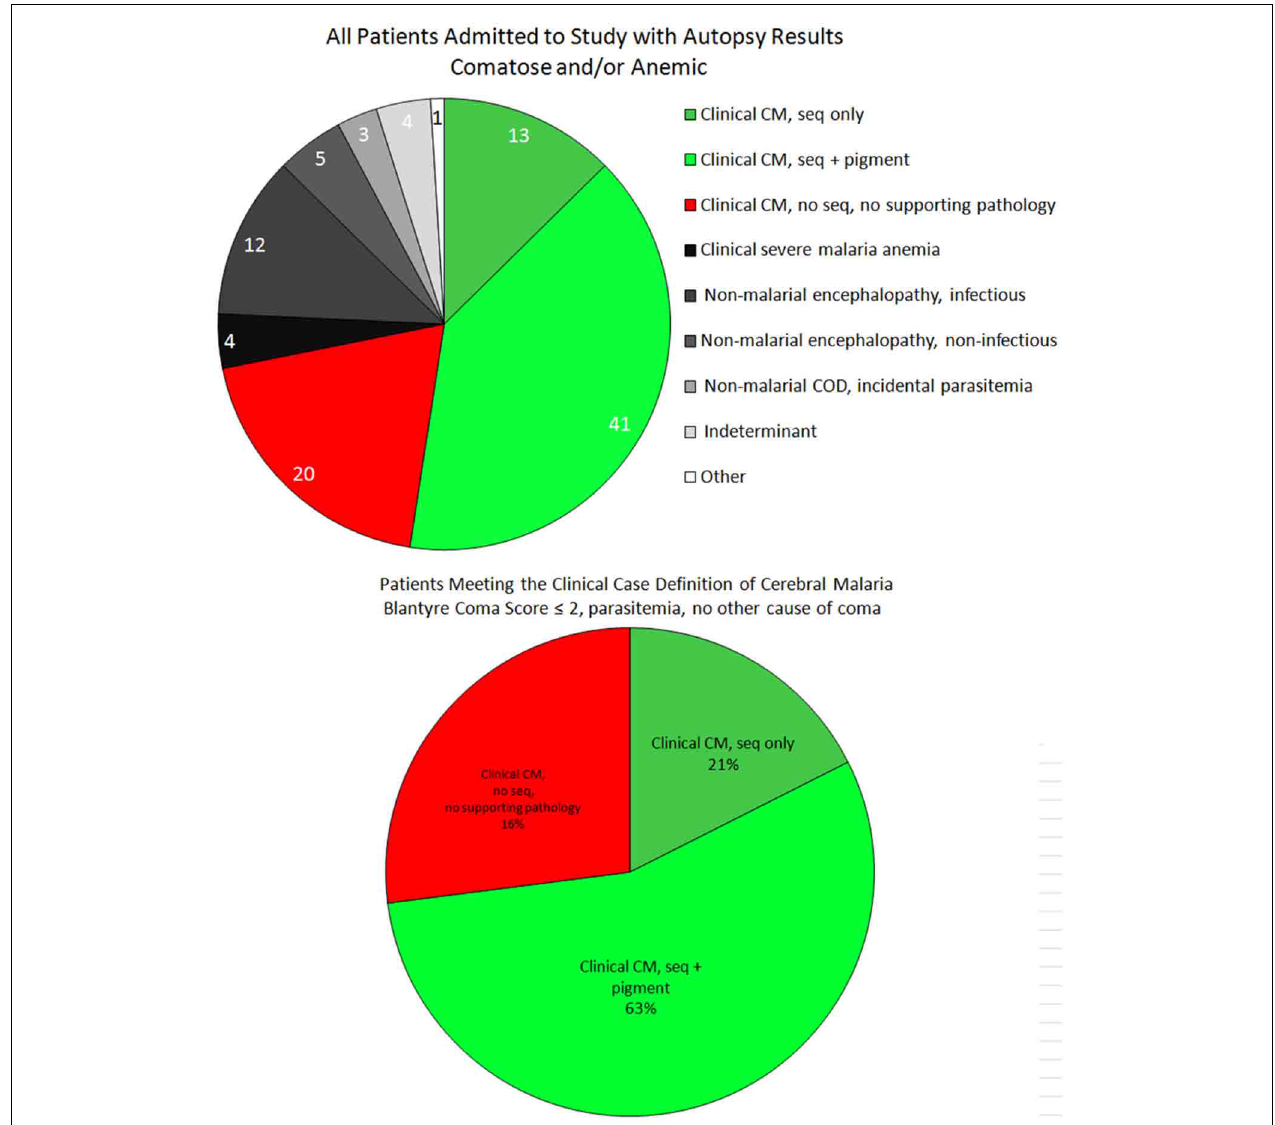
FIGURE 1 | The case distribution of all autopsies between 1996 and 2010 is presented for all final diagnoses (top). These included patients who were admitted to the research ward who were either comatose or anemic (with or without parasitemia). Among patients who satisfied the clinical case